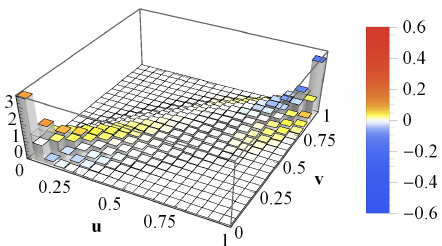
Figure 13. Average loss copula histograms for two portfolios with heterogeneous volatilities drawn from a uniform distribution in the interval ( 0,0.25 ) . The color bar indicates the local deviations from the corresponding Gaussian copula. Taken from (Sicking et al.